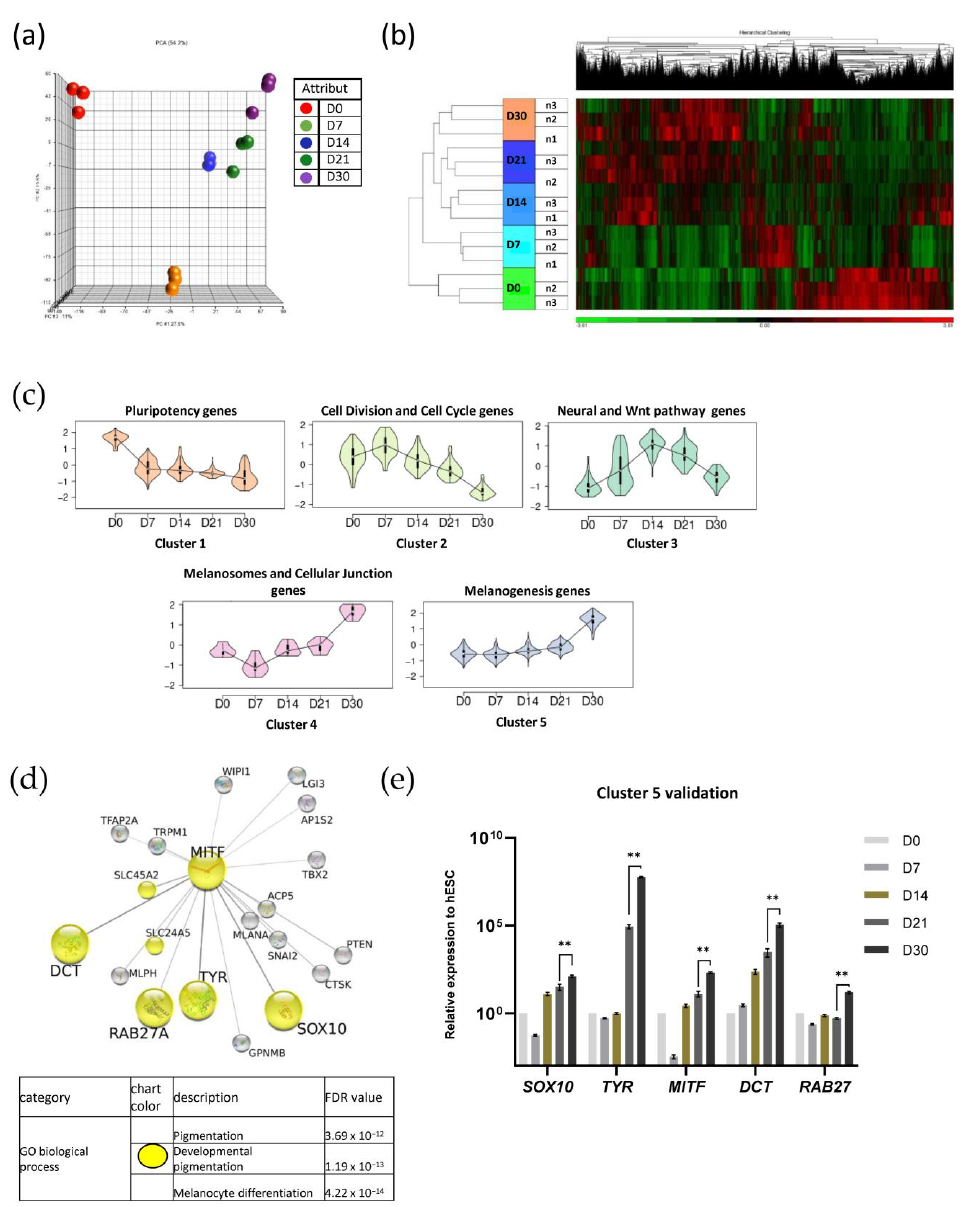
Figure 4. Transcriptional analysis of Mel-hESC during the differentiation process in a time-dependent manner. ( a ) Principal components analysis (PCA) of each differentiation time point (day 0: D0, day 7: D7, day 14: D14, day 21: D21, and day 30: D30). ( b ) Hierarchical clustering of gene expression at D0, D7, D14, D21, and D30 ( n = 3). ( c ) Graphics of 5 clusters. Clustering of genes statistically differentially expressed during differentiation and regrouped with the same expression profile. ( d ) (Upper) Gene network linked to MITF. The 328 genes contained in cluster 5 are analyzed in STRINGdb (with medium confidence 0.4). The global network obtained is sent to Cytoscape to